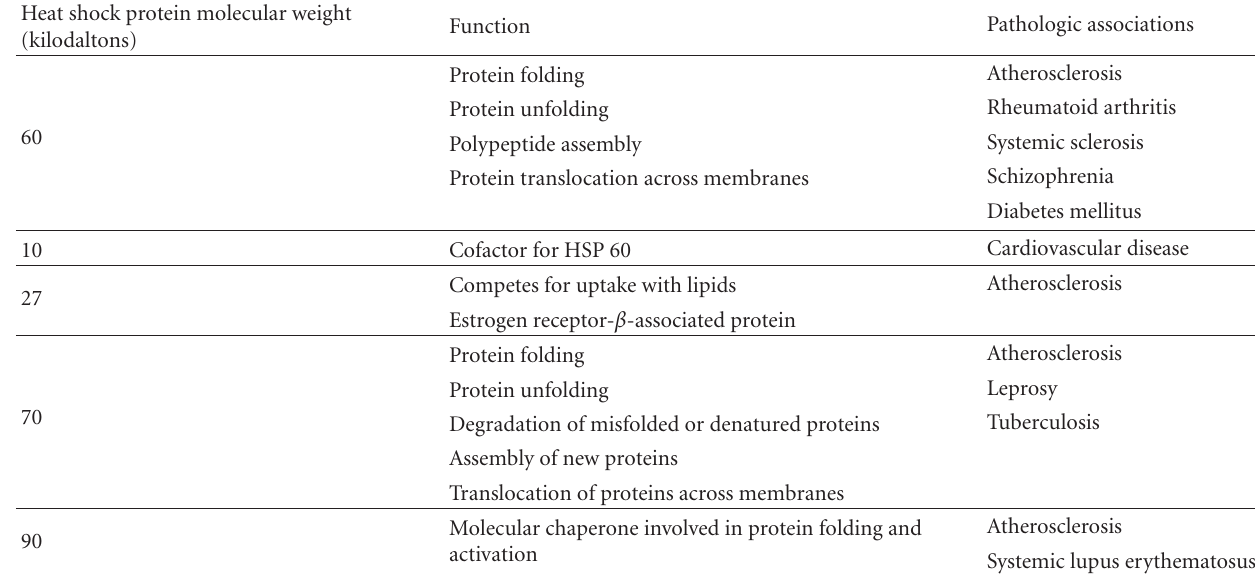
Table 1: Functions of heat shock